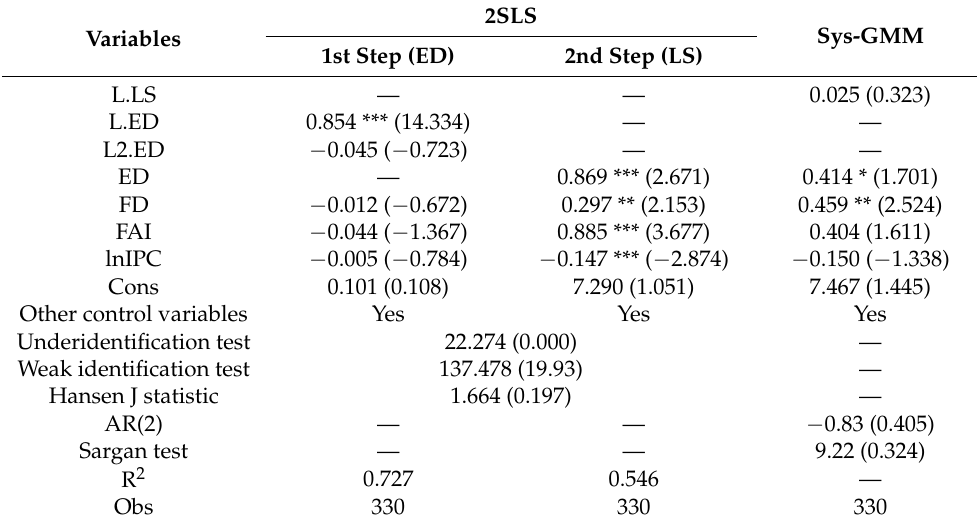
Table 5. Endogenous test